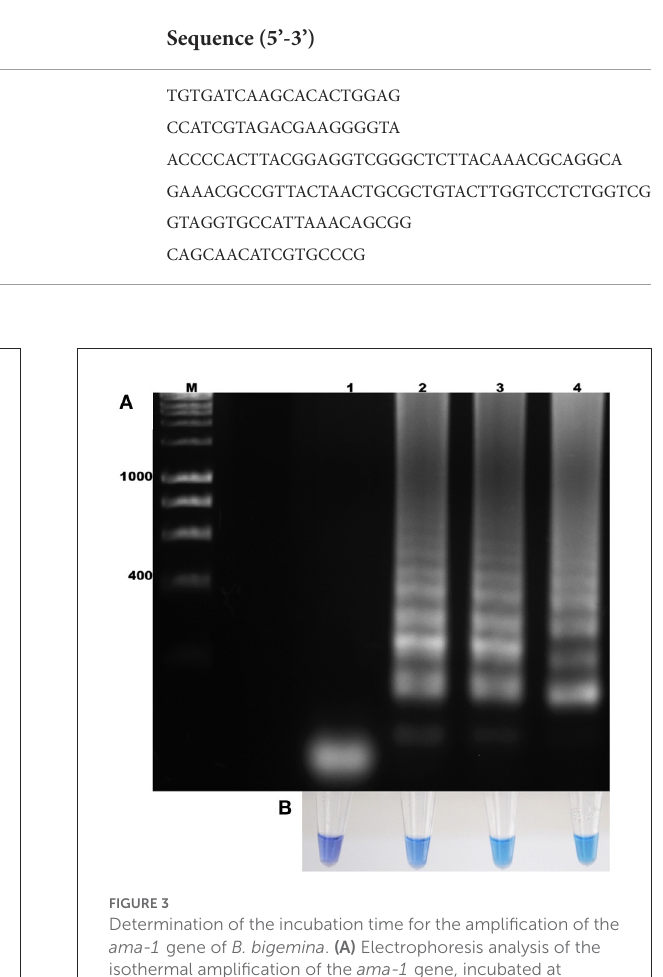
TABLE 1 Sequence and size of the designed primers.